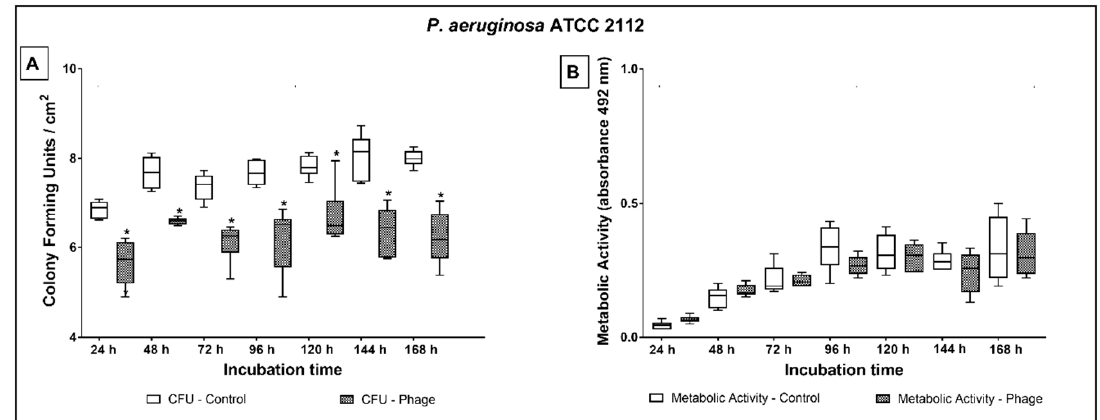
Figure 5. Biofilm growth ( A ) and metabolic activity ( B ) of P. aeruginosa ATCC 2112 over 24 to 168 h of dynamic biofilm growth on non-coated and phage cocktail-coated tubes. Comparisons were conducted among groups, at each time point, by means of multiple comparisons considering strains and phage cocktail treatment in a generalized linear model with Bonferroni correction. * indicates statistically significant difference at each time point ( p < 0.05).